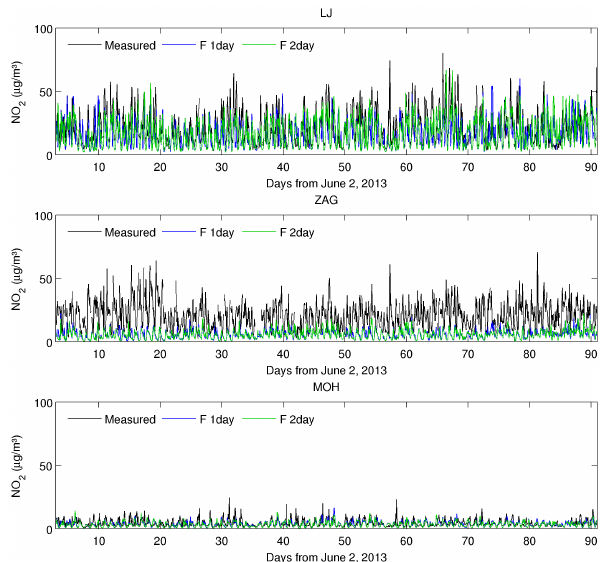
Figure 6. The same as Fig. 5 but for NO 2 at the LJ, ZAG and MOH stations.